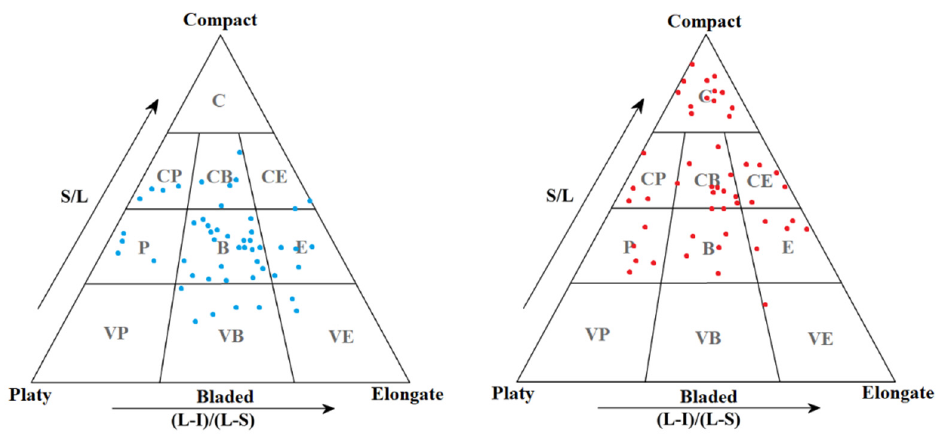
Figure 5. Clast shape classification diagram [27]. On the left, the light blue dots correspond to naturally shaped samples, and the red dots on the right represent artificially fractured samples. After breakage, the shapes became more compact.